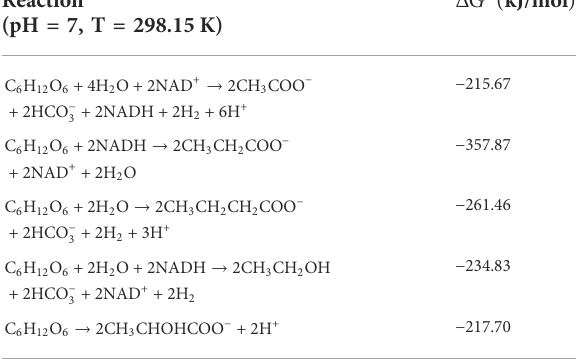
TABLE 1 Standard Gibbs free energy change of glucose fermentation. Reaction (pH = 7, T = 298.15